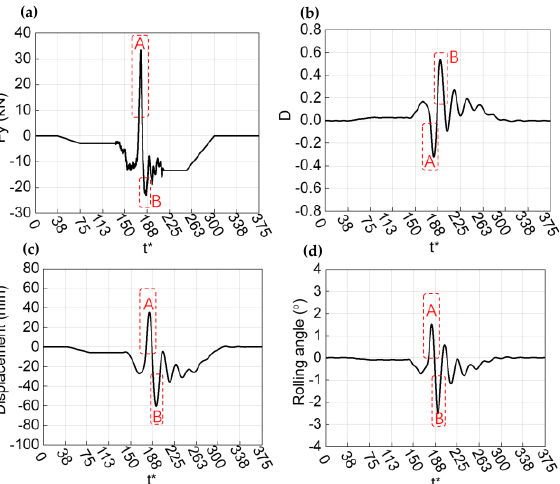
Figure 18. Vehicle dynamic model: ( a ) bogie model and ( b ) entire train model.